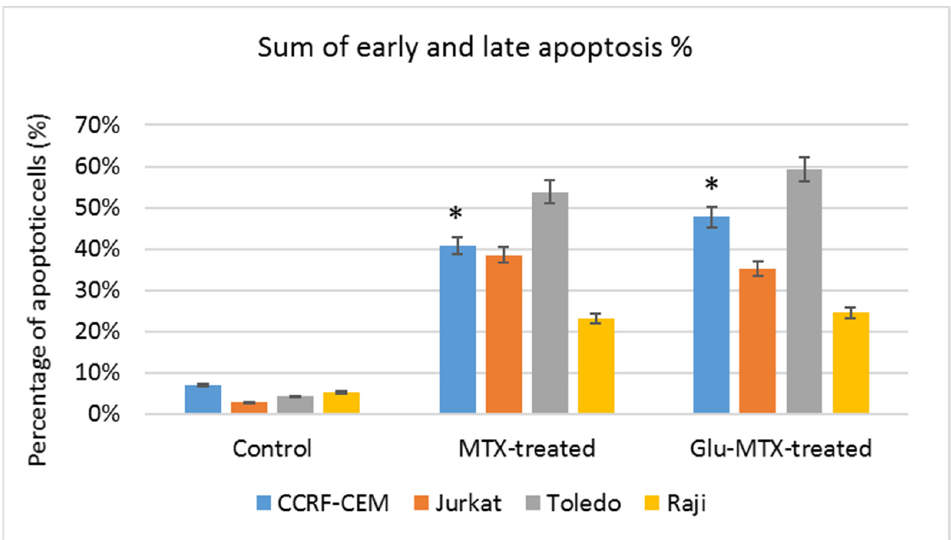
Figure 5. The percentage of early and late apoptotic cells after treatment with MTX and Glu–MTX. The statistical analysis of differences between control and treated sample was performed using an independent samples t -test. * p < 0.05 was indicated as statistical significance, comparing MTX- treated cells with Glu–MTX-treated.